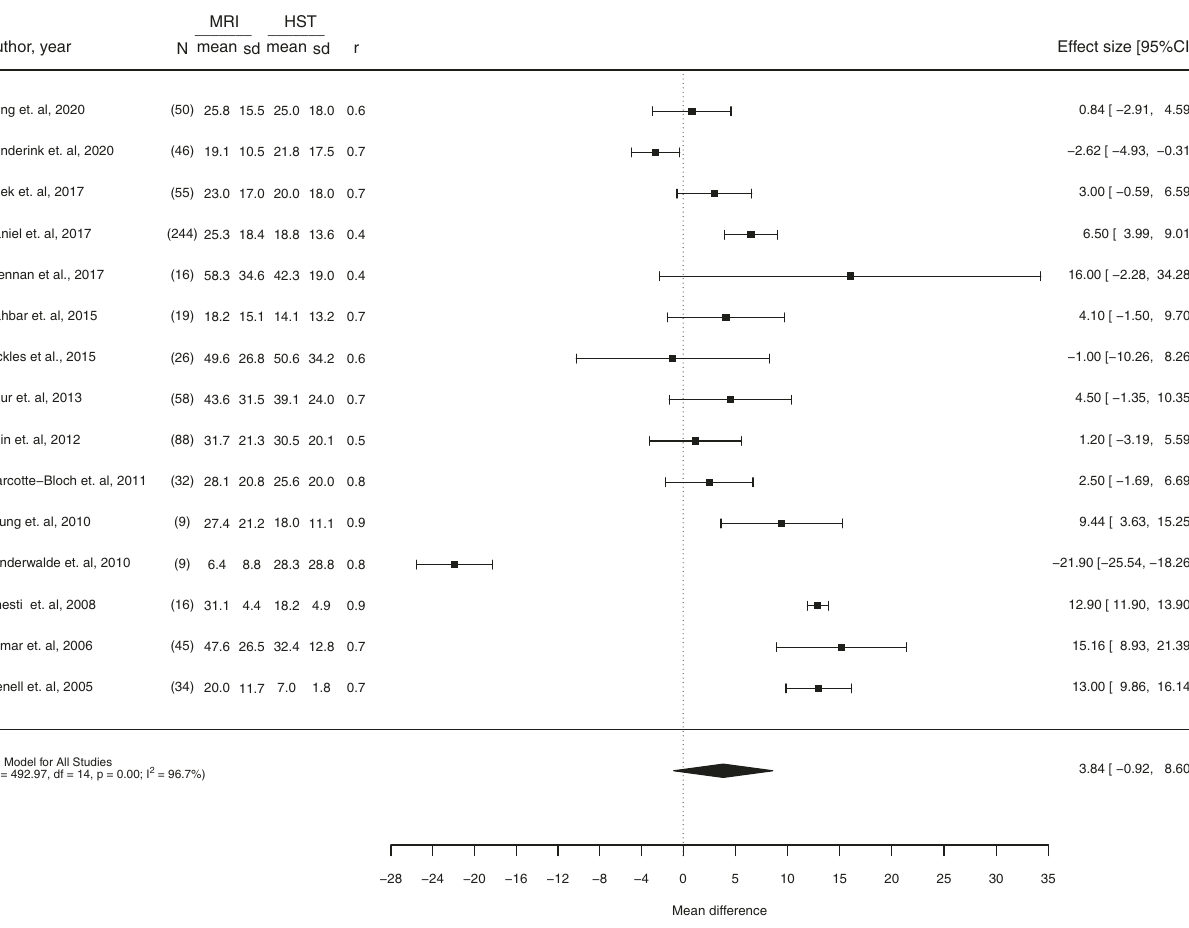
Fig. 3 Mean size difference between MRI and pathology across studies. Pooled results of the mean size difference of paired measurements of DCIS with MRI and Pathology (HIST), using an imputation method, for all the eligible studies.